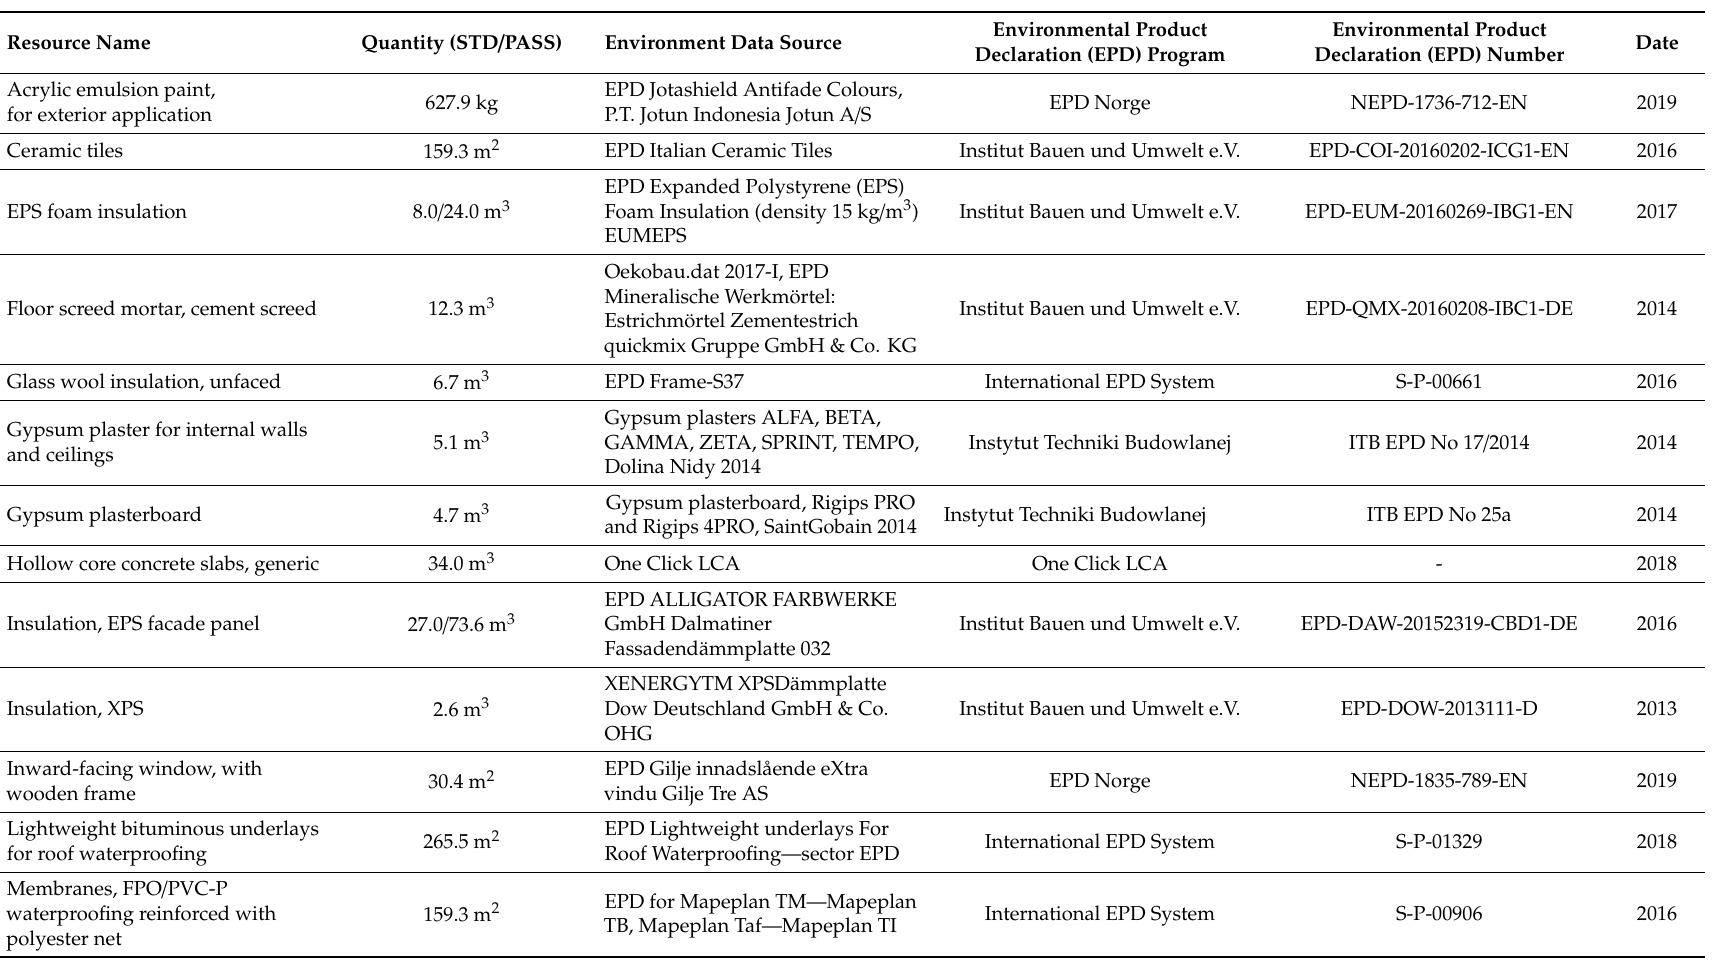
Table A1. The full data source for GWP calculation used in One Click LCA program—brick